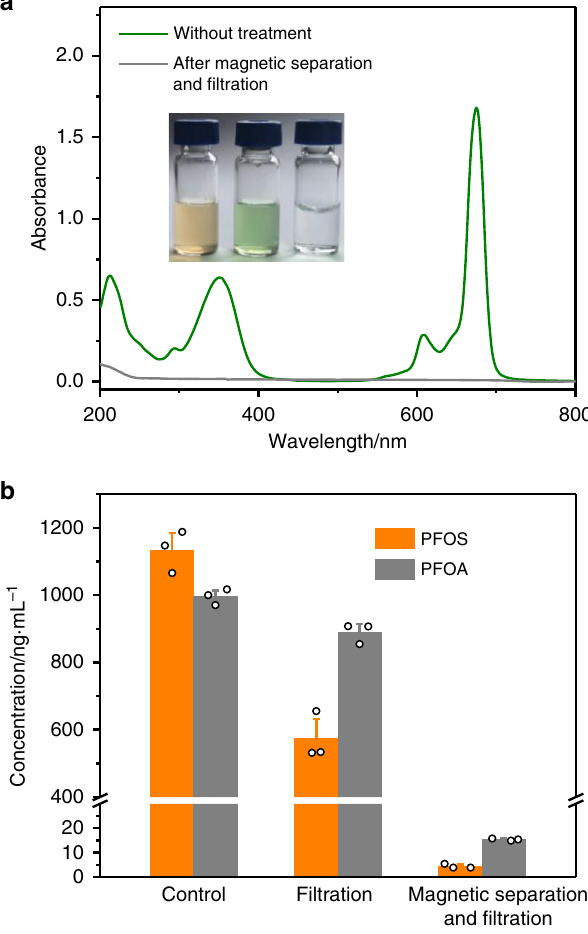
Fig. 8 Absorption of AlPcS 4 , PFOS, and PFOA in water samples. a Absorption spectra of AlPcS 4 (10 μ M) without any treatment and after magnetic separation by MNP@GC5A-12C and fi ltration. (Inset) Photographs of MNP@GC5A-12C ([GC5A-12C] = 100 μ M) (left), MNP@GC5A-12C ([GC5A-12C] = 100 μ M) with AlPcS 4 (10 μ M) (middle), and the fi ltrate after magnetic separation and fi ltration (right). b Concentrations of PFOS and PFOA with only fi ltration, and with both magnetic separation and fi ltration are quanti fi ed by the UPLC – ESI-MS/MS system. Concentrations of PFOS and PFOA without magnetic separation are shown as a control. Error bars in ( b ) represent mean ± s.d. ( n = 3 independent experiments).